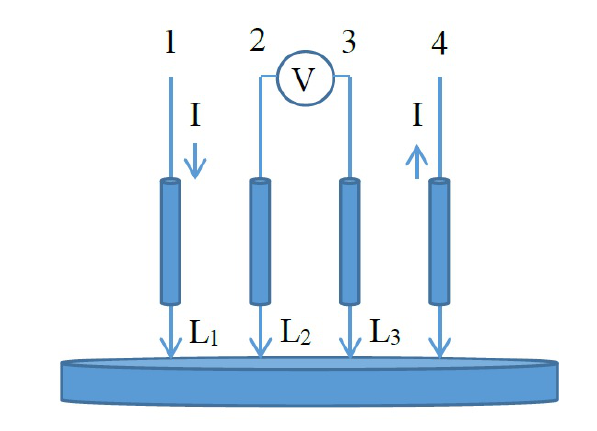
Figure 1: Four-probe scheme for electrical resistivity measurement, redrawn according to Ref.